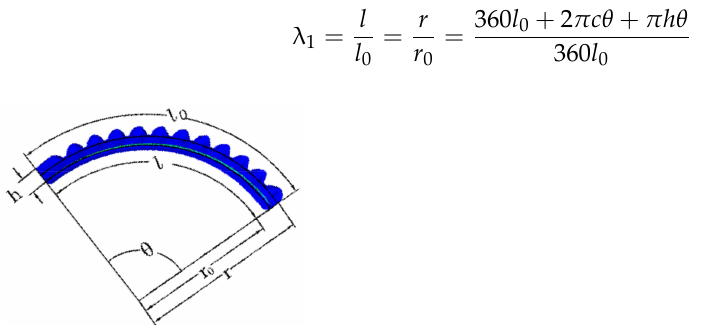
Figure 4. Bending deformation of